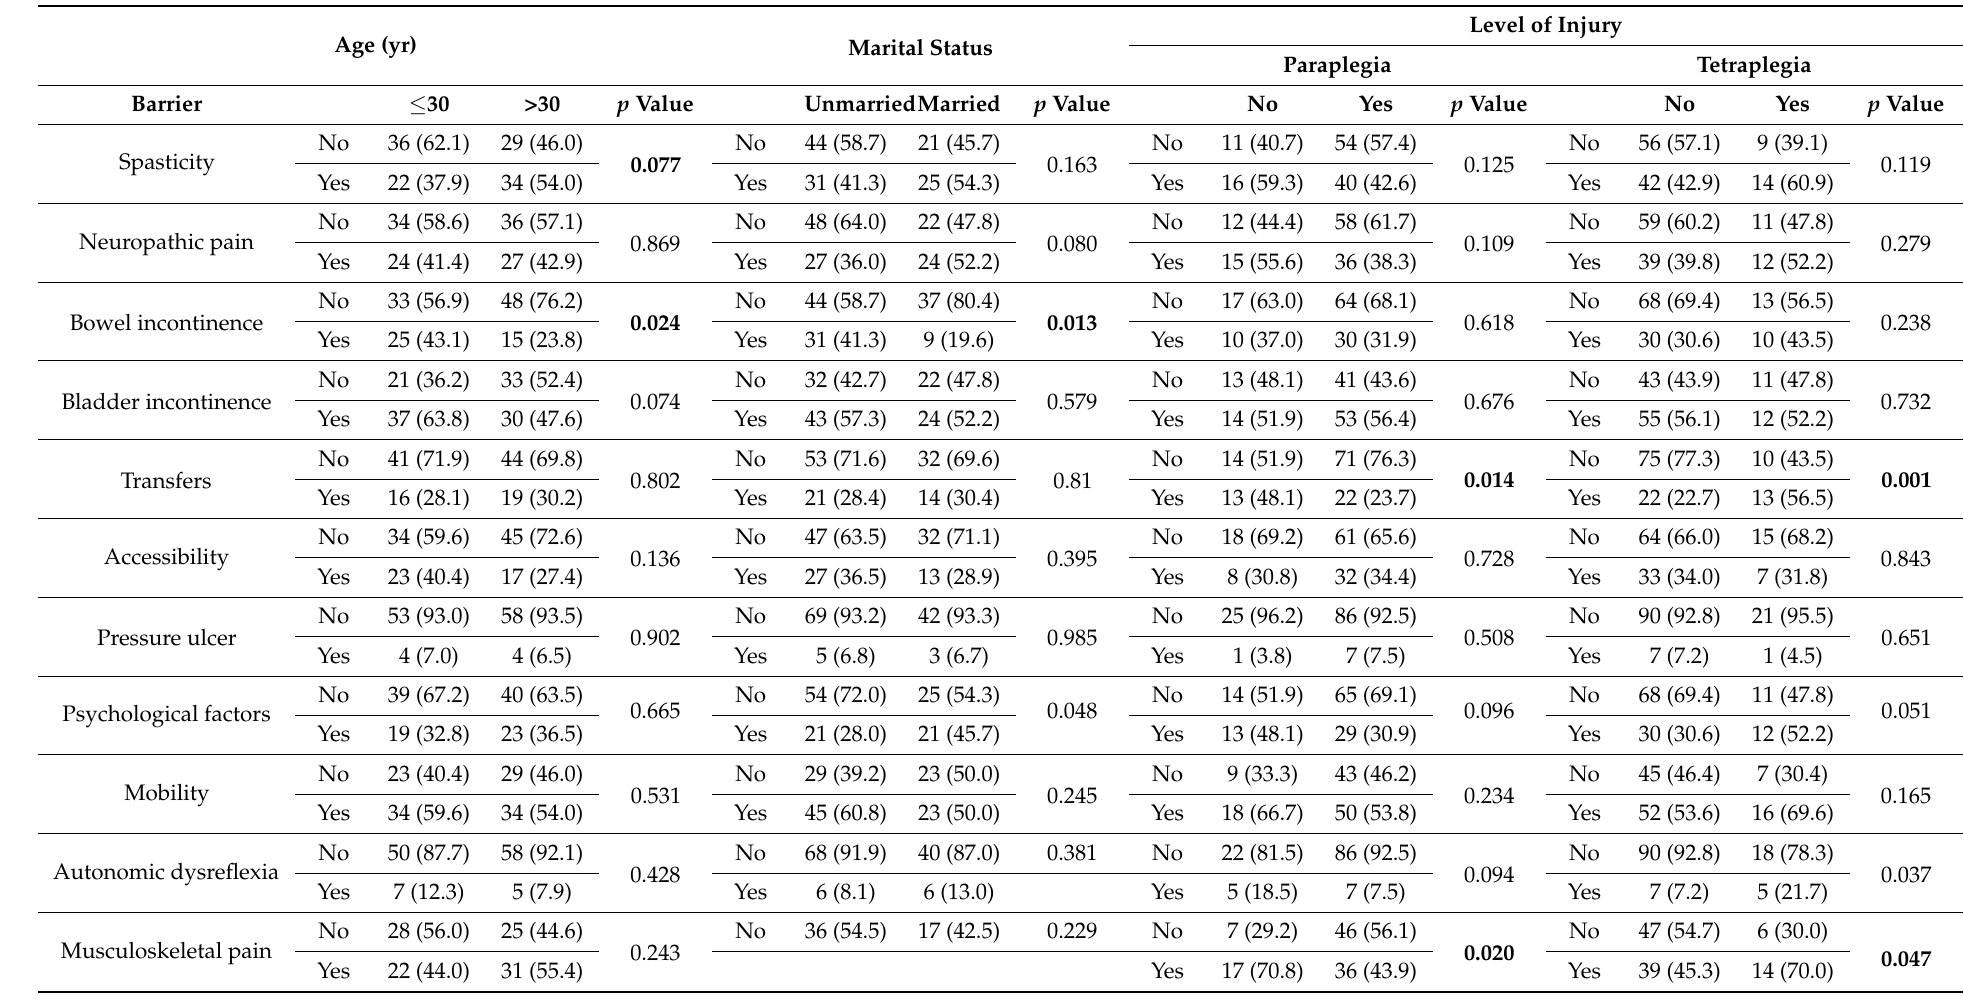
Table 3. Perceived clinical barriers to employment after spinal cord injury in relation to age, marital status and level of injury. Age (yr) Marital Status